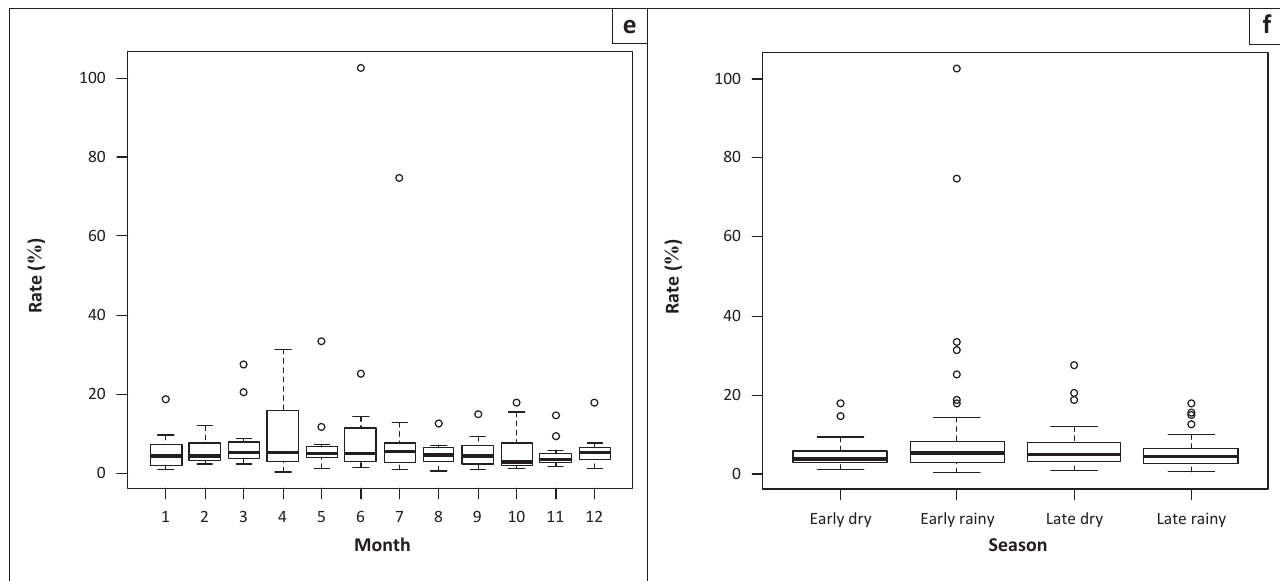
FIGURE 3-A2 (Continues...): Monthly and seasonal rate of throughput, slaughter of pregnant animals and foetal wastage for goats, Minna Metropolitan Abattoir, Nigeria, during 2001–2012. (a) Monthly throughput for goat, (b) seasonal throughput for goat, (c) monthly slaughter of pregnant goat, (d) seasonal slaughter of pregnant goat, (e) monthly rate of foetal wastages in goat and (f) seasonal rate of foetal wastages in